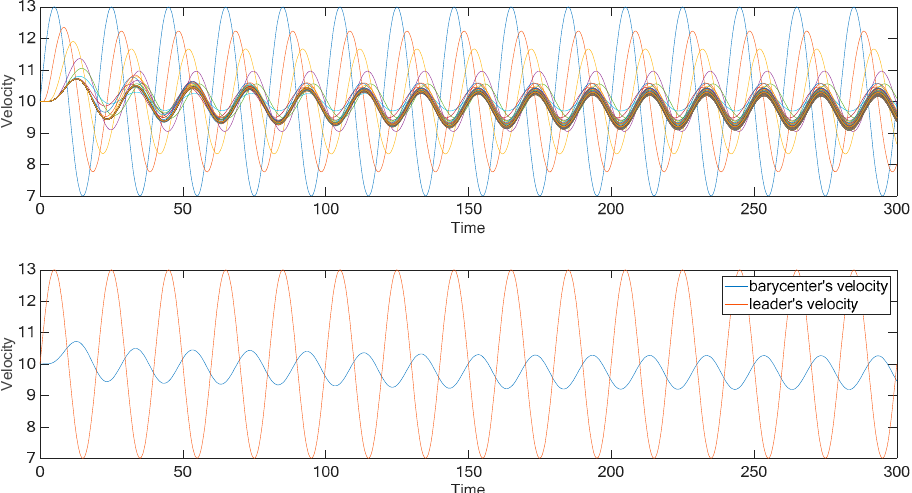
Figure 24. The small-world model studied in Figure 11 for a connection fail of vehicle 21 after 100 s. On top, the velocity of each vehicle that follows the leader, on the bottom, the velocity of the leader and the one of the barycenter of the system of 500 vehicles, plotted versus time.